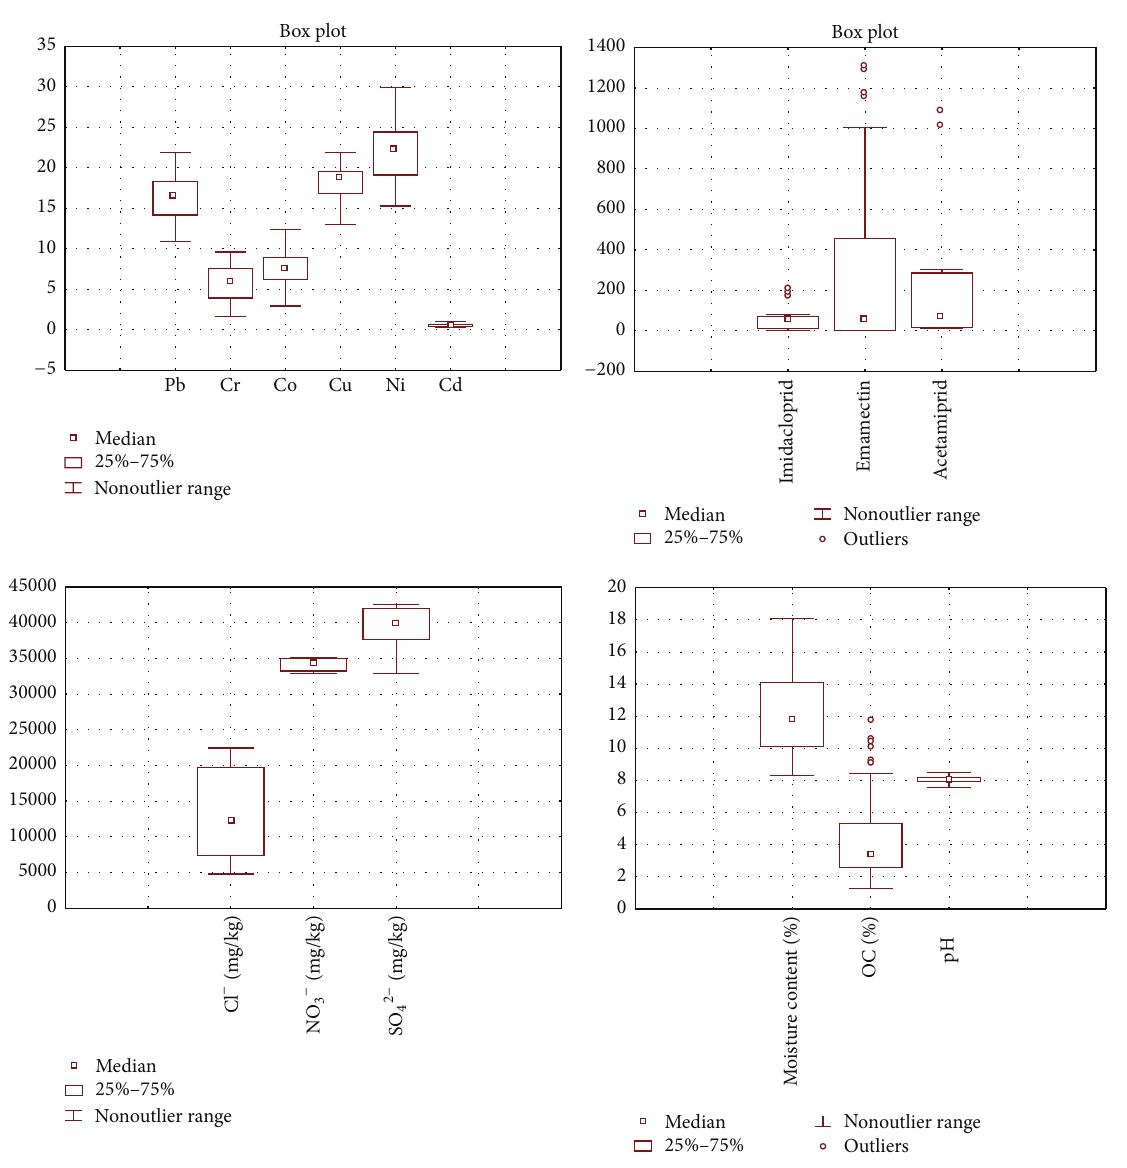
Figure 2: Box and Whisker plots for the distribution of various parameters in